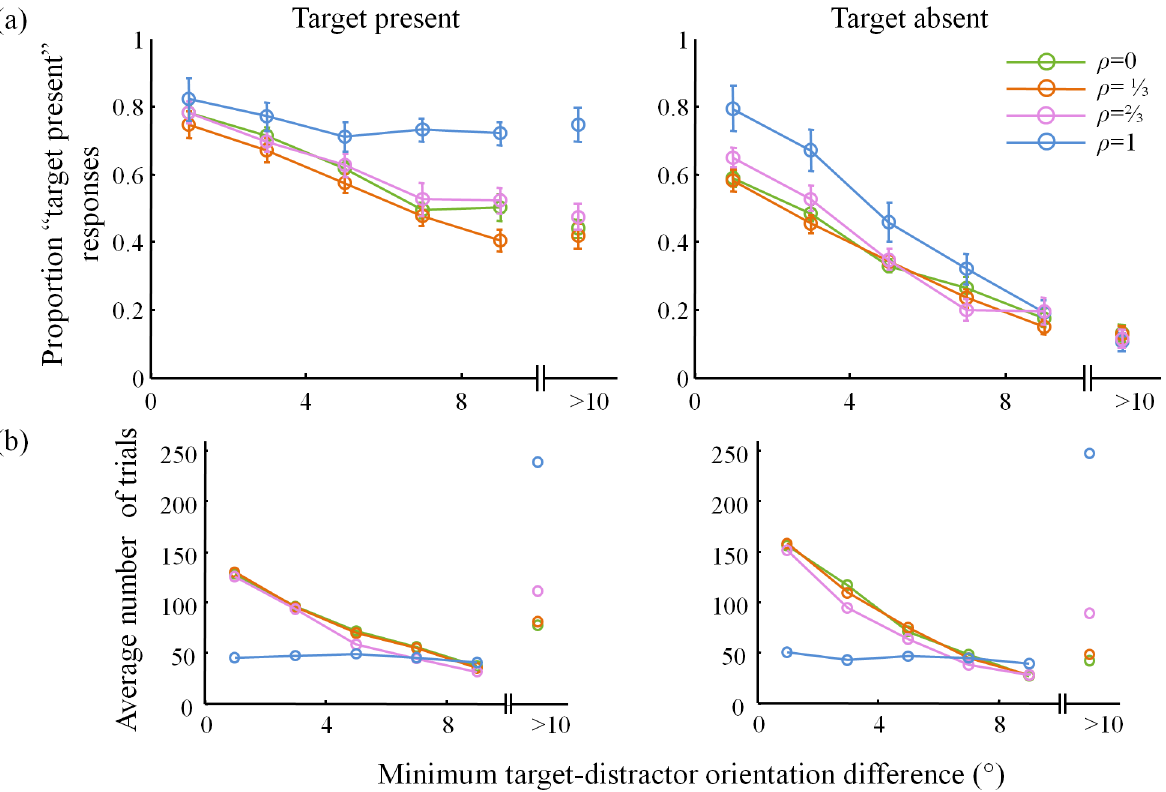
Fig 4. Psychometric curves 3. (a) Proportion “ target present ” responses and (b) number of trials as a function of minimum target-distractor orientation difference for target present (left) and absent (right) trials. Bin size was 2°, except that all trials with minimum target-distractor orientation difference greater than 10° are collected in the last bin. The plots in (b) are entirely determined by the stimuli, not by the subject responses; they help to reconcile the plots in (a) with Fig 2b.